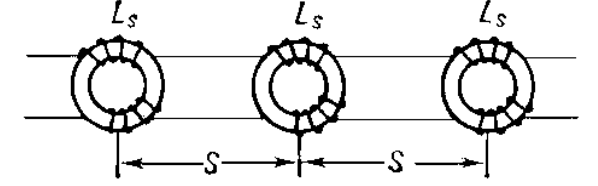
Fig. 7. Scheme of including inductors in a telephone line according to M.